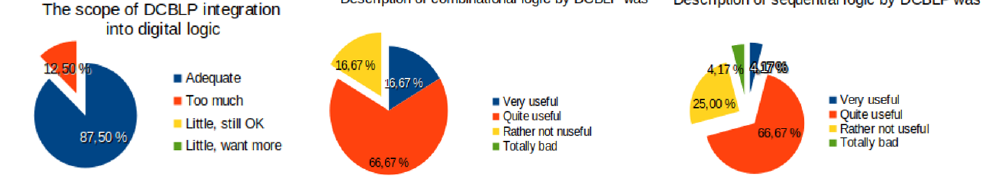
Figure 9. Questions related to usefulness of the programming